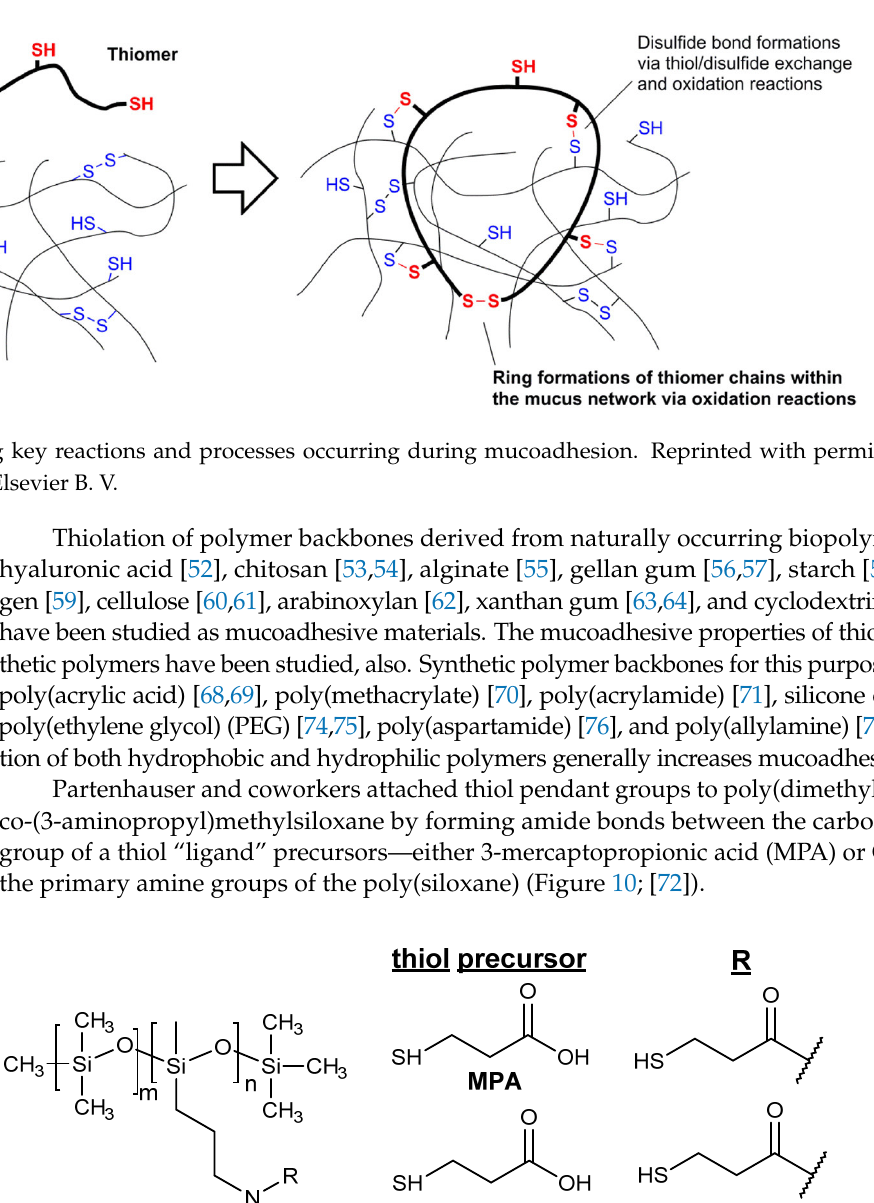
Figure 10. Thiolated silicone oils bearing 3-mercaptopropionic acid (MPA) or cysteine (Cys) pendant groups synthesized by Partenhauser et al.